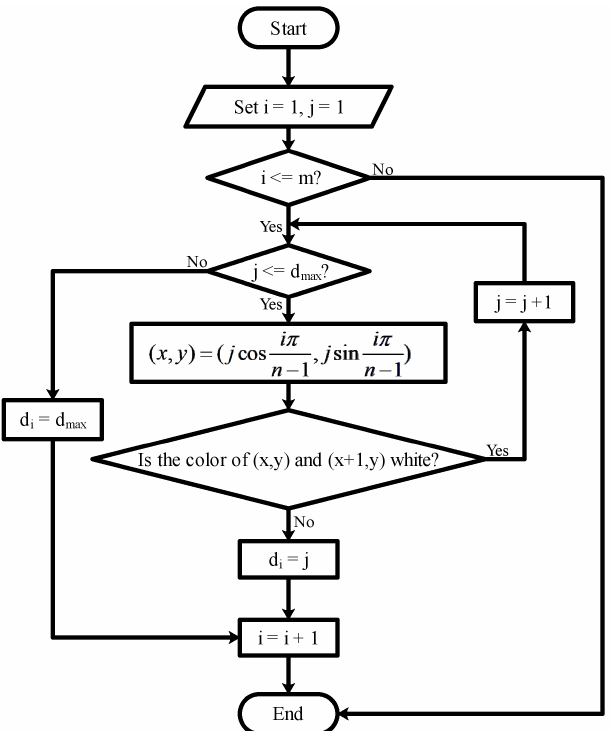
Figure 3. The complete mechanism flow utilized to generate laser ranging information in RoNAP.